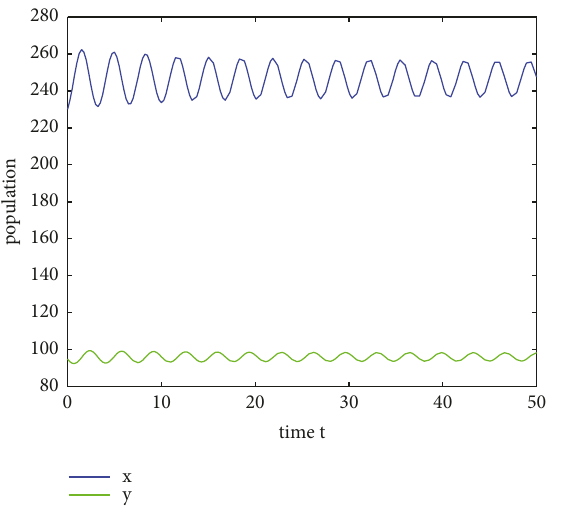
Figure 11: A Time series diagram for prey and predator. Existence of periodic solution around the interior equilibrium 𝐸 ∗ = (𝑥 ∗ ,𝑦 ∗ ) for delayed model (3) with the time delays 𝜏 1 = 0 and 𝜏 2 = 1.5 , where the parameter values are 𝑥(0) = 230 , 𝑦(0) = 95 , 𝐴 = 0.01 , 𝑟 = 2.65 , 𝐾 = 900 , 𝑎 = 0.02 , 𝑐 = 0.215 , and 𝑚 = 1.06 .